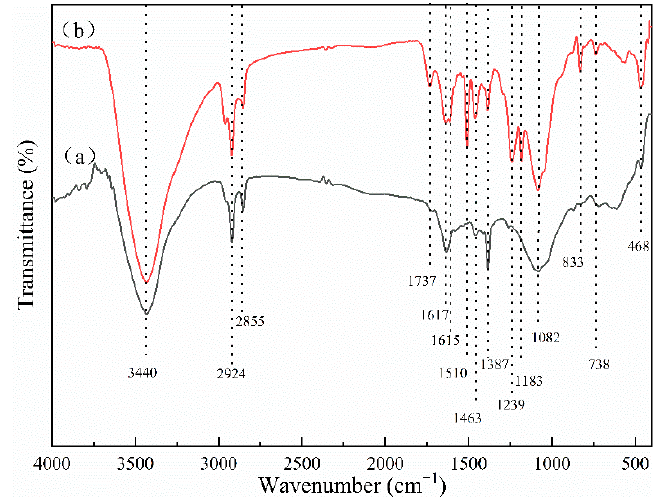
Figure 5. FT-IR spectra of graphite in bacterial growth after coculture for 5 days: ( a ) before co-culture; ( b ) after co-culture (other conditions: 1.6 pH, 0.5 g/L graphite, 45 °C, 170 rpm).